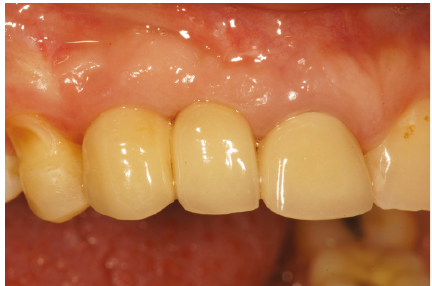
Figure 6: Occlusal view of the gingival conditioning.